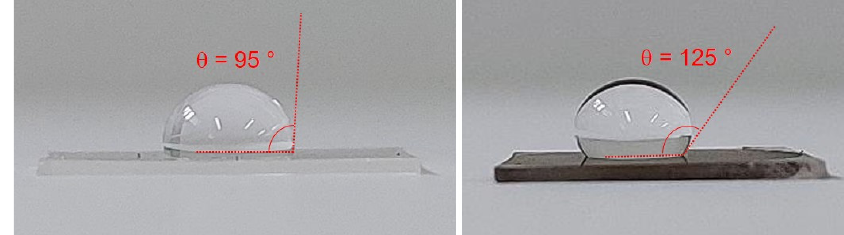
Figure 3. Contact angle values of GL-MAPLE film and neat PDMS surface.